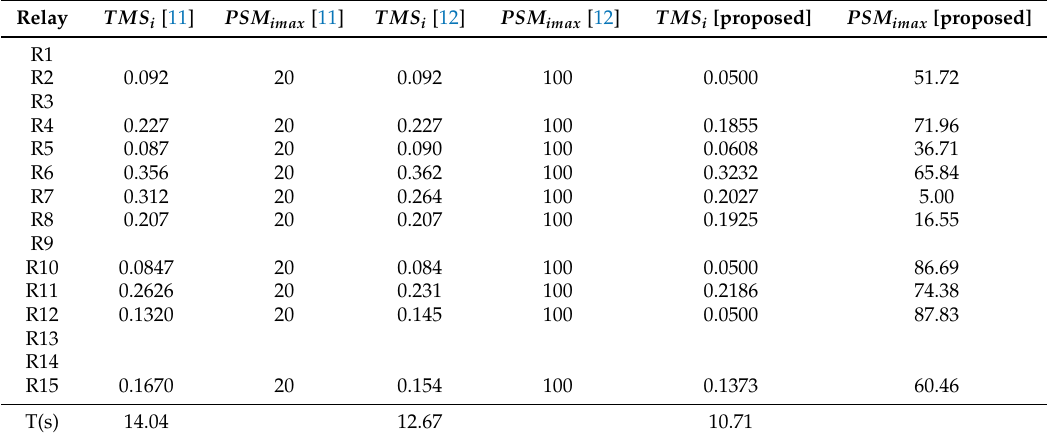
Table 7. Coordination parameters for OM3.